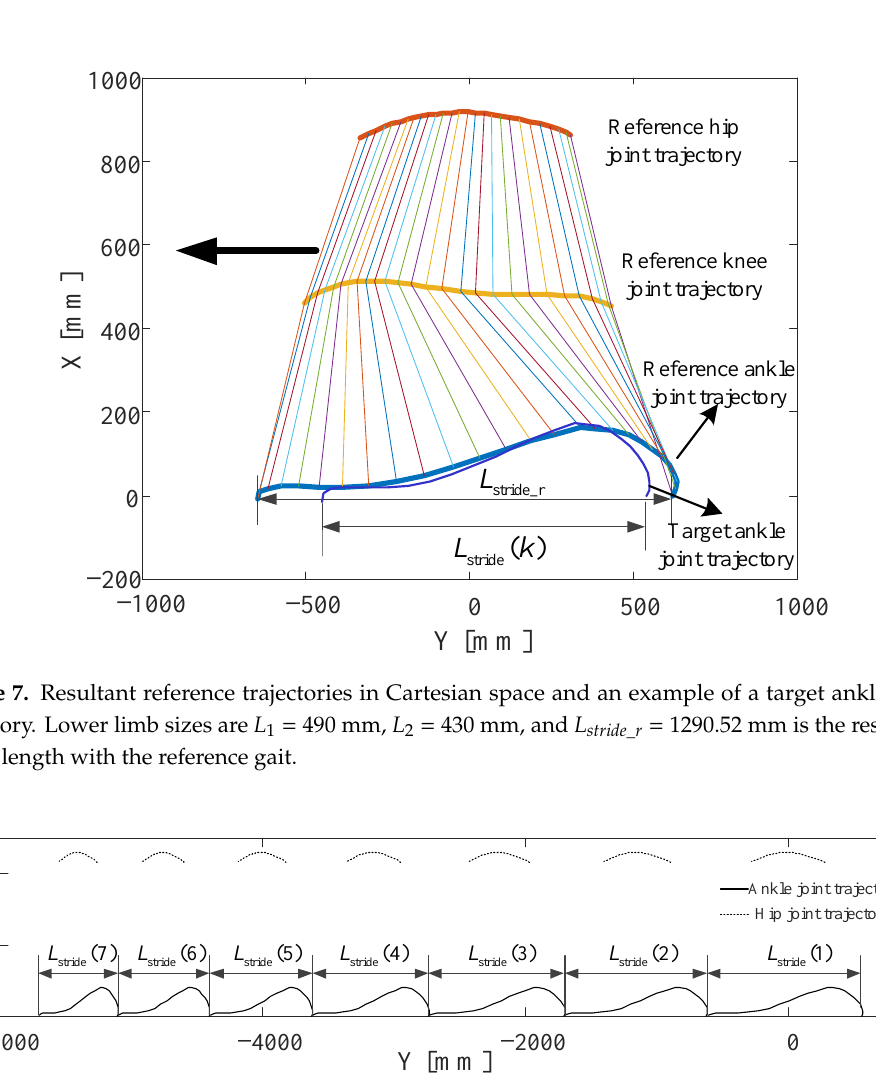
Figure 9. Exoskeleton-assisted walking test procedure. The subject was told to press buttons 1 and 2 before walking and signal sampling, respectively. The subject was reminded with buzz 1 that the current gait was finished, and with buzz 2 that signal sampling was completed. The gaits of the first and last steps were predefined and independent of CoP.